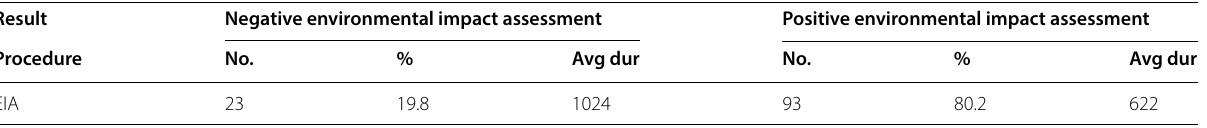
Table 18 EIA results and average duration Result Negative environmental impact assessment